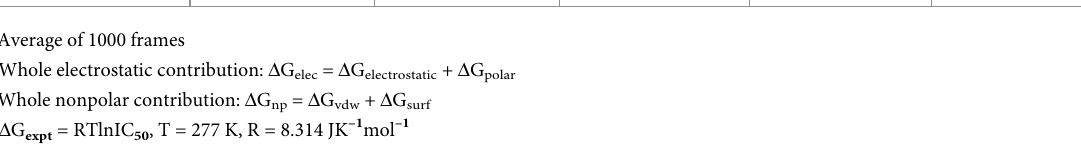
S2 Fig. Ramachandran plot of the initial homology modeled S . aureus HK/WalK structure.